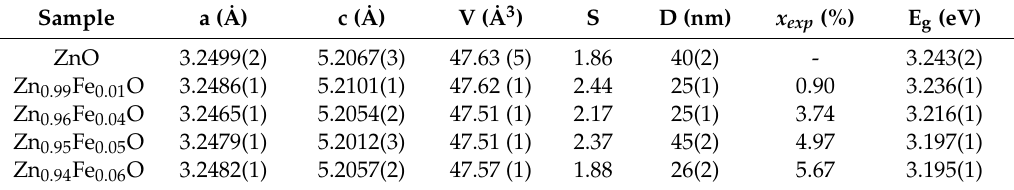
Table 1. Crystallographic parameters, refinement goodness (S = R wp / R exp ), crystallite sizes (D), measured iron concentrations (x exp ), and energy band gaps obtained for the Zn 1 − x Fe x O samples.